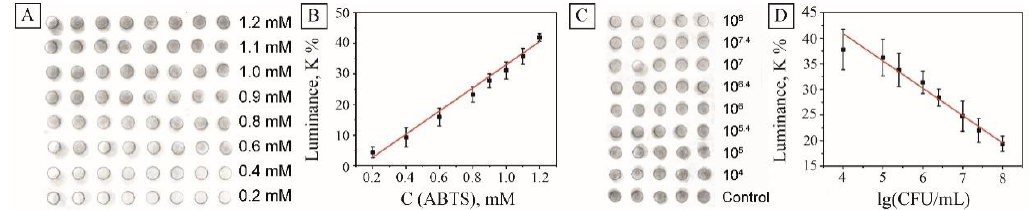
Figure 6. Device-free evaluation of the printed sensors. Processed image of the sensor array with various ABTS concentrations ( A ); the dependence of the measured sample luminance on ABTS concentration after 10 min of incubation ( B ); processed image of the sensor array in the presence of various amounts of E. coli CFU, ( C ); the dependence of the measured sample luminance on E. coli concentration after 10 min of incubation ( D ).